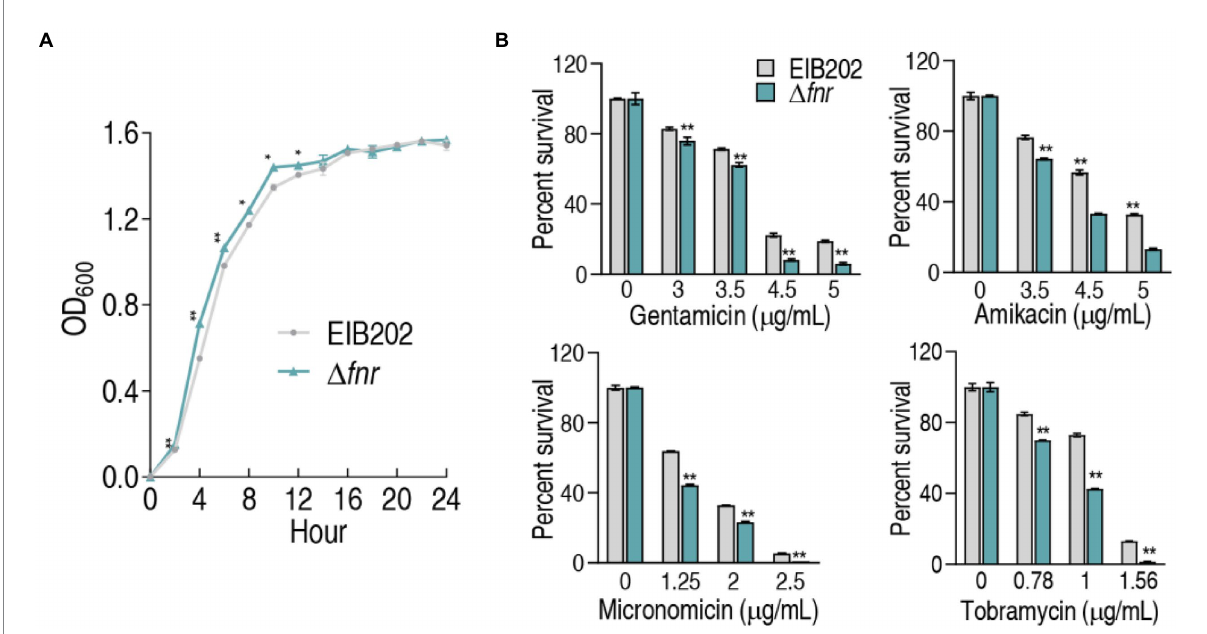
FIGURE 1 Growth and survival of genetically modified strains of fnr deletion. (A) Growth curve of EIB202 and Δ fnr . (B) Survival of Δ fnr and its parent strain EIB202 to aminoglycoside antibiotics. Results are displayed as means ± SEM, and significant differences are identified ( * p < 0.05; ** p < 0.01) as determined by Student’s t -test. At least three biological repeats were carried